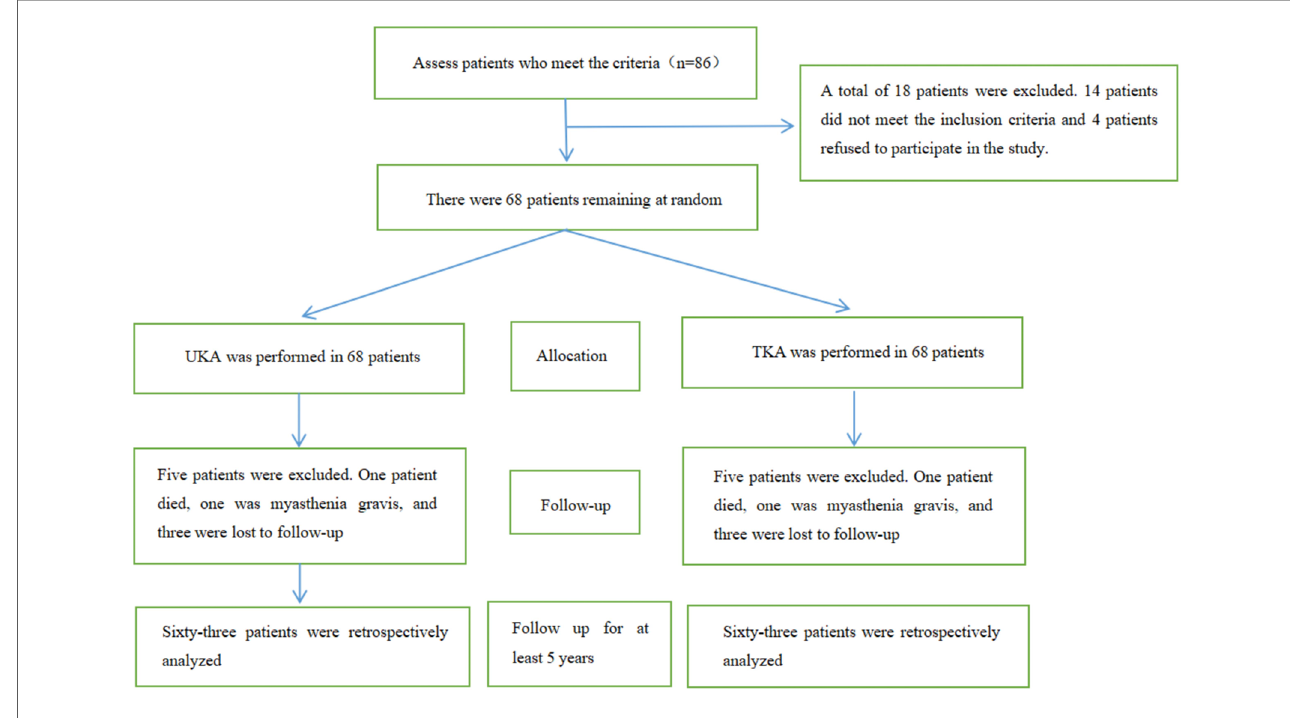
FIGURE 1 Study fl owchart.